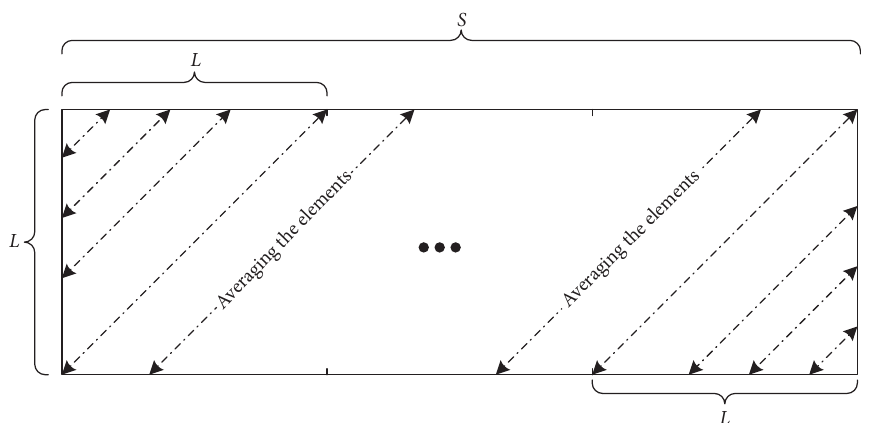
Figure 1: Visualization of diagonal averaging using singular spectrum